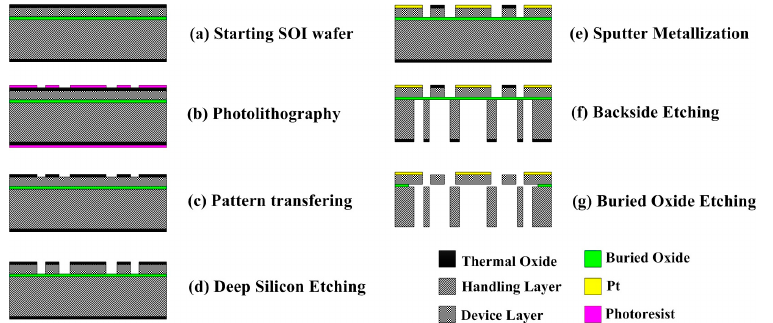
Figure 4. Fabrication process of the proposed tuning fork gyroscope. ( a ) Starting SOI wafer; ( b ) photolithography; ( c ) pattern transferring; ( d ) deep silicon etching; ( e ) sputter metallization; ( f ) backside etching; ( g ) buried oxide etching.